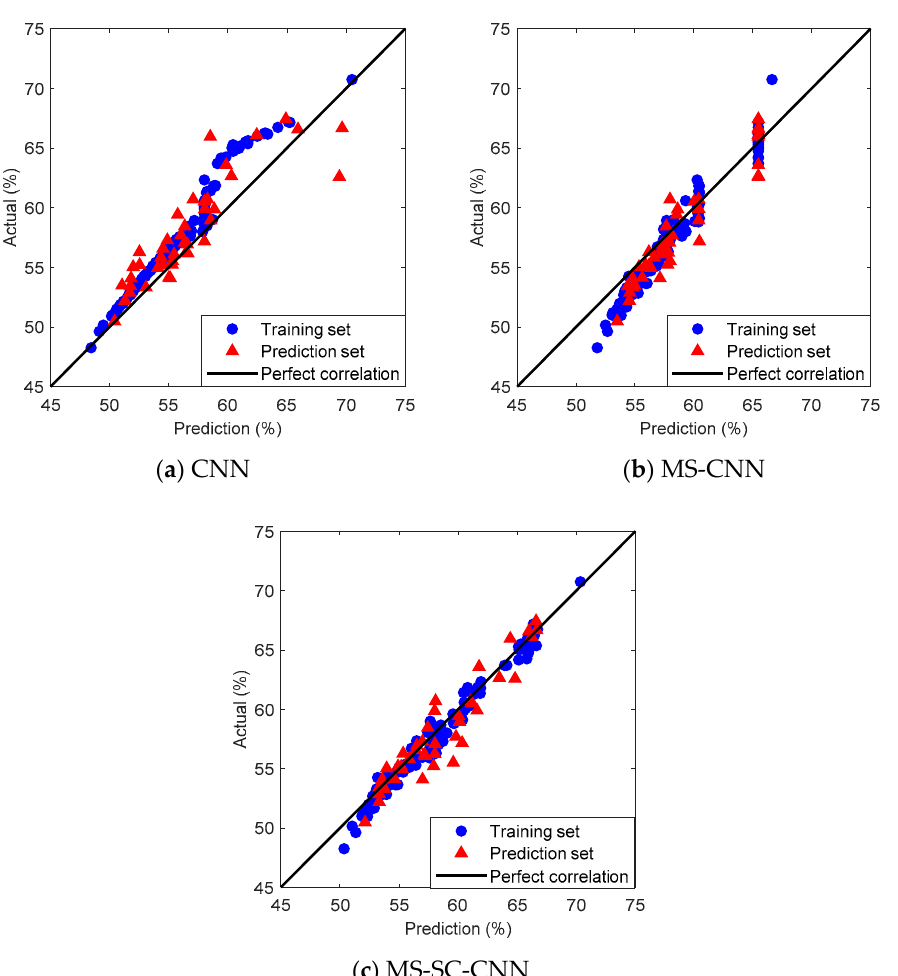
Figure 4. Measured vs. predicated moisture content for Pinus massoniana seedling leaves by the regression models of the convolutional neural network (CNN) ( a ), the multi-scale convolutional neural network (MS-CNN) ( b ) and the multi-scale short cut convolutional neural network MS-SC- CNN ( c ).